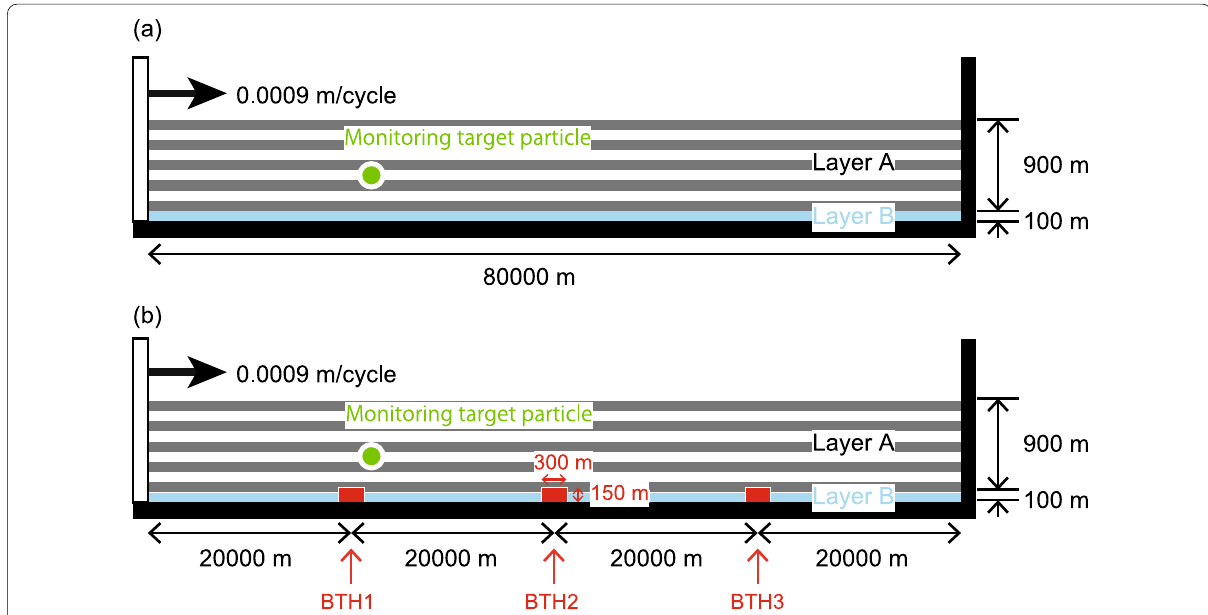
Fig. 1 Set-ups for the numerical simulations a without BTHs for the reference model (Fig. 2) and b with BTHs for the multiple BTH collision model (Fig. 3). The red rectangular symbols are the BTHs consisting of fixed particles. The green symbols mark the initial locations of the monitoring particles, which are the monitoring points for the stress state and porosity (Fig. 5)